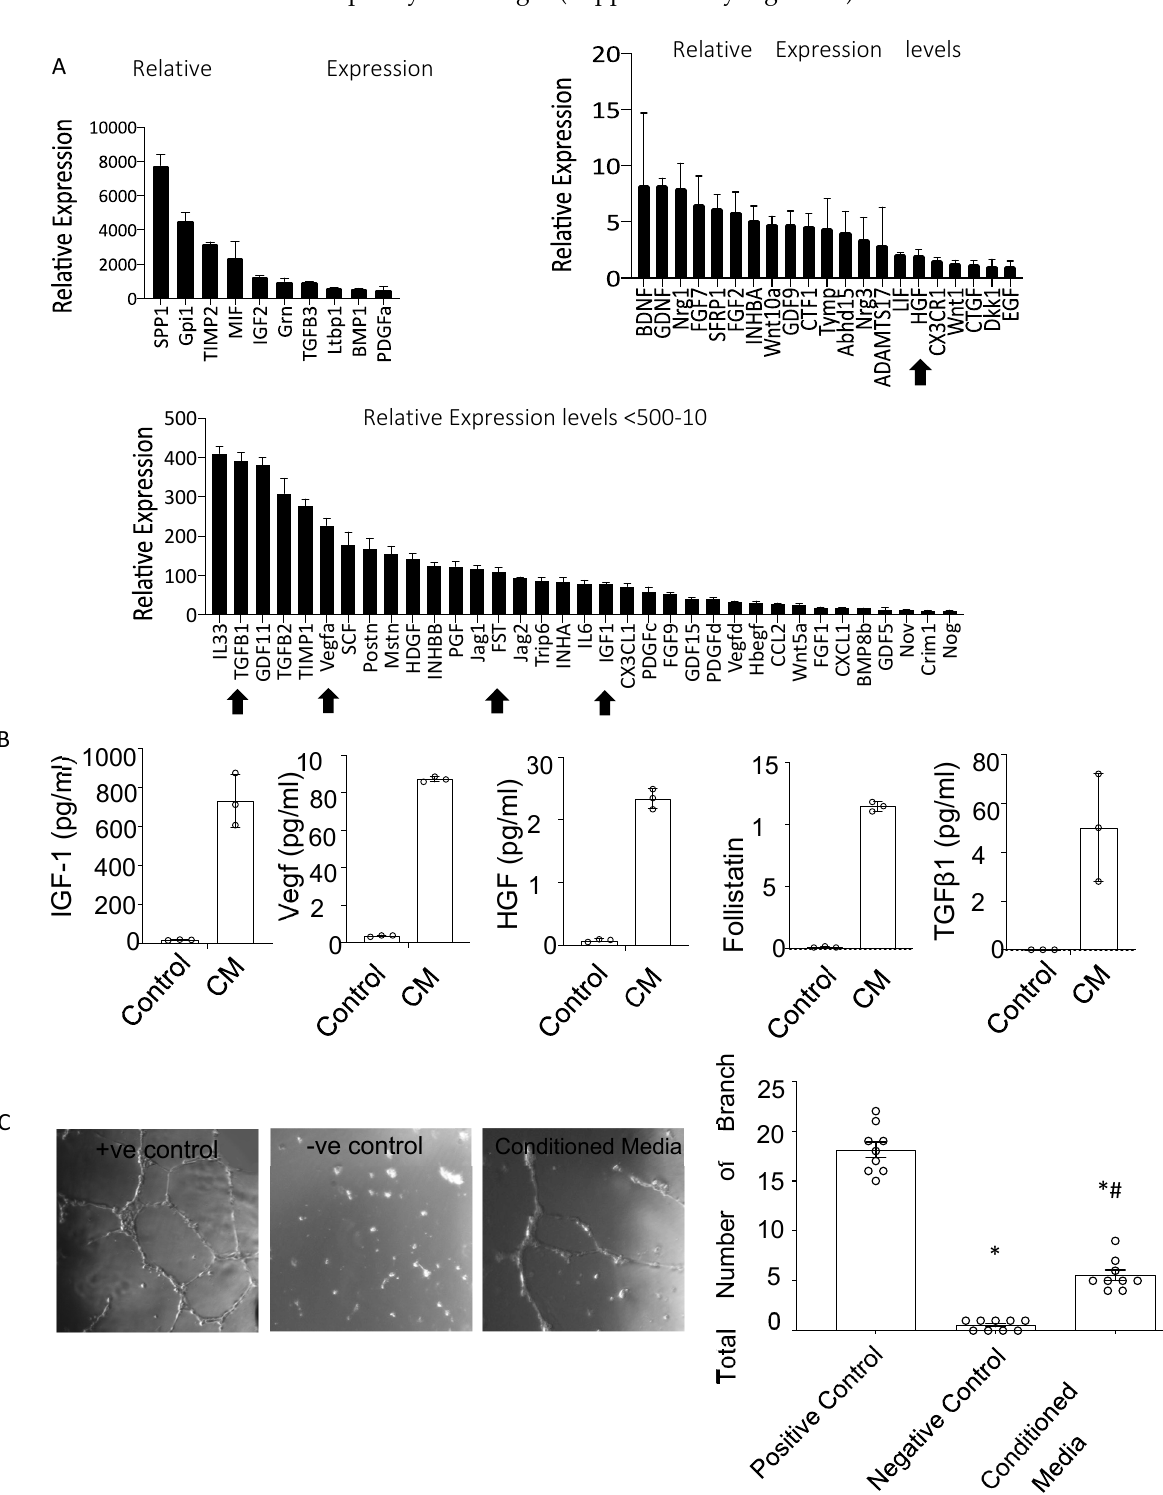
Figure 5. PICs have a pro-reparative secretome . ( A ) Pro-survival and regenerative transcript expres- sion of PICs. Data are relative expression to housekeeping genes GAPDH, ß-actin and B2M. Gene profile relative expression levels are depicted as, >500, 500–10 and <10. Data are Mean ± SD, n =